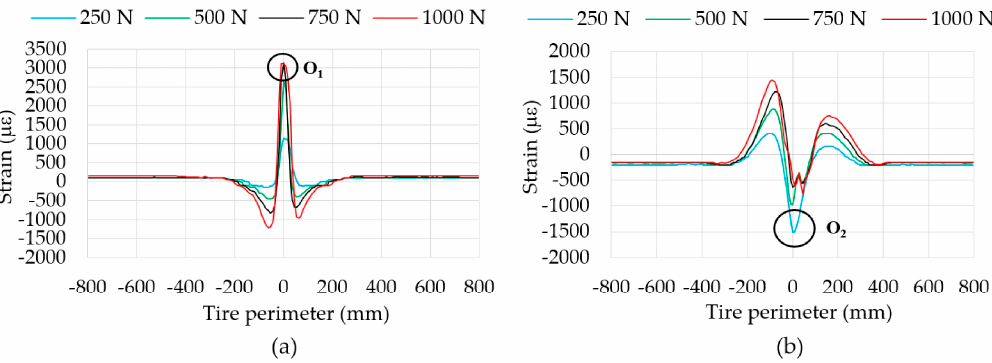
Figure 11. ( a ) Comparison of curves for different vertical loads in ε x at 1 bar, 30 km/h; ( b ) Comparison of curves for different vertical loads in ε y1 at 1 bar, 30 km/h.